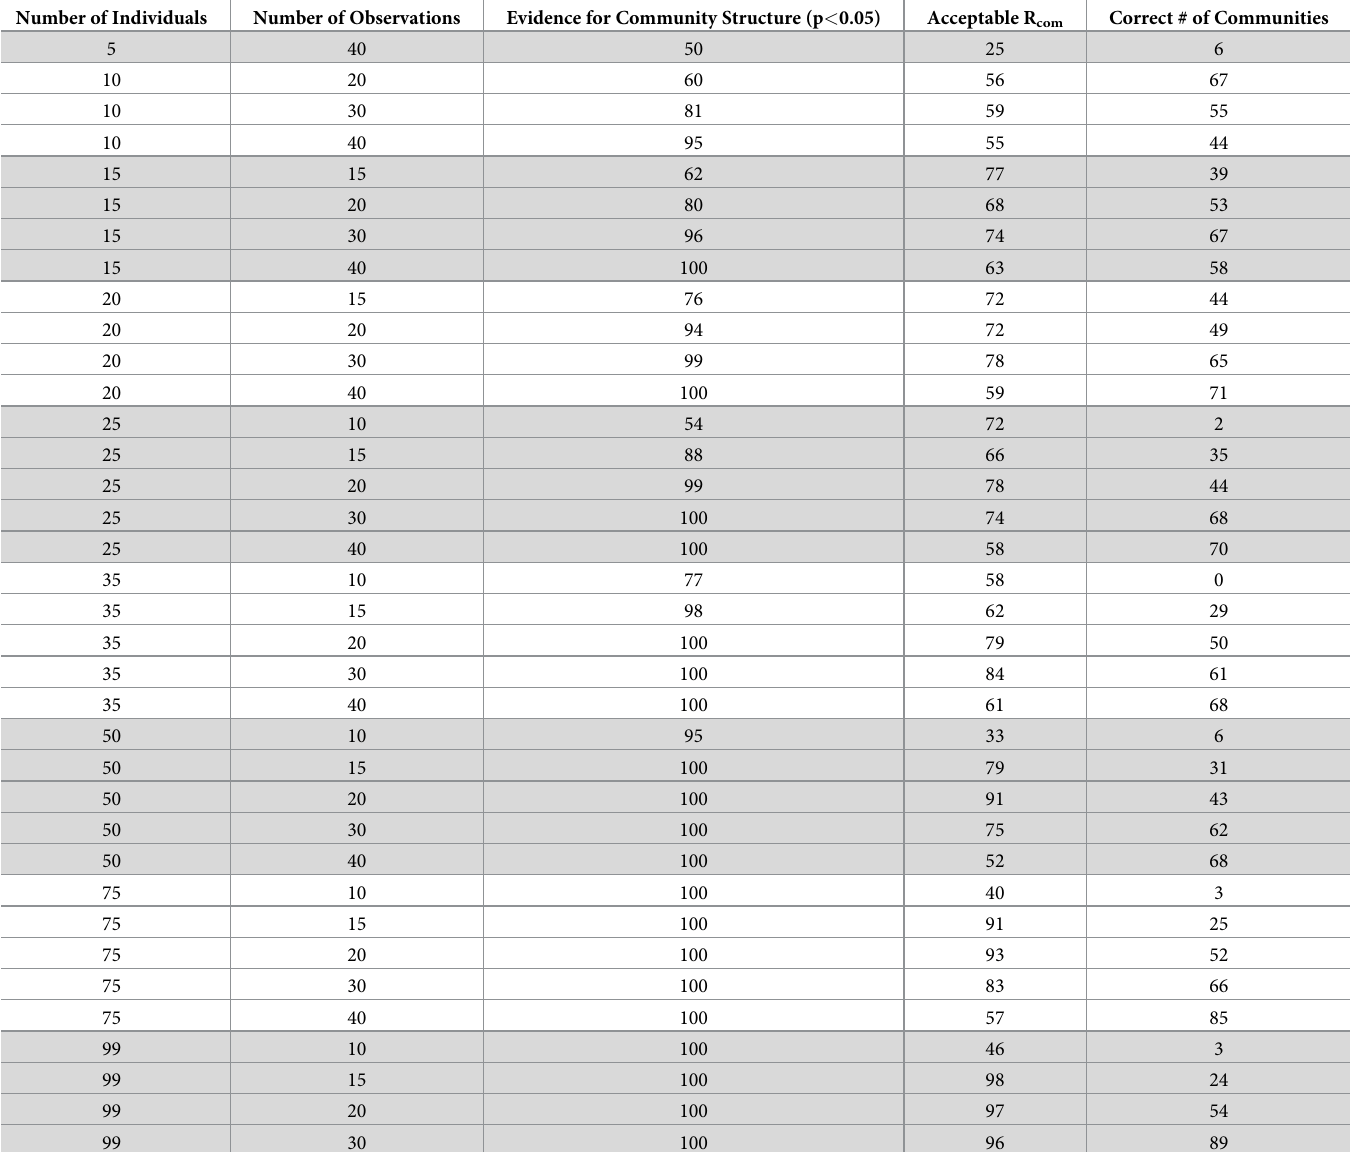
Table 1. All sampling regimes (number of individuals and number of observations per individual) where there was sufficient evidence to detect community struc- ture in at least half of all 100 replicates. Number of Individuals Number of Observations Evidence for Community Structure (p <